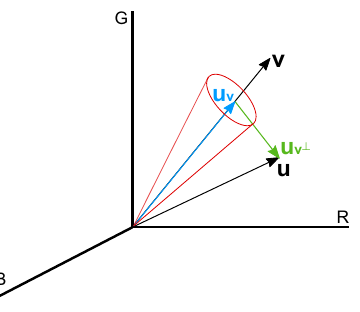
Figure 4. Three-dimensional representation of an example of the cone that restricts the acceptable colors given the vectors v and u